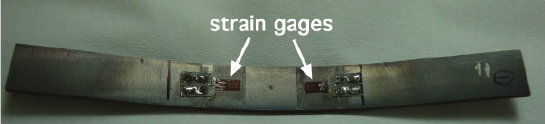
Figure 4 – Four point bending sample after compression test.